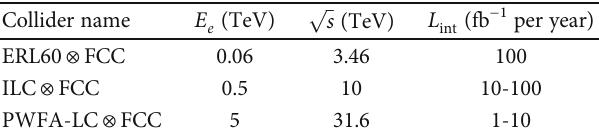
Table 1: Main parameters of the FCC-based ep colliders with the = 50 TeV. proton beam energy of E p